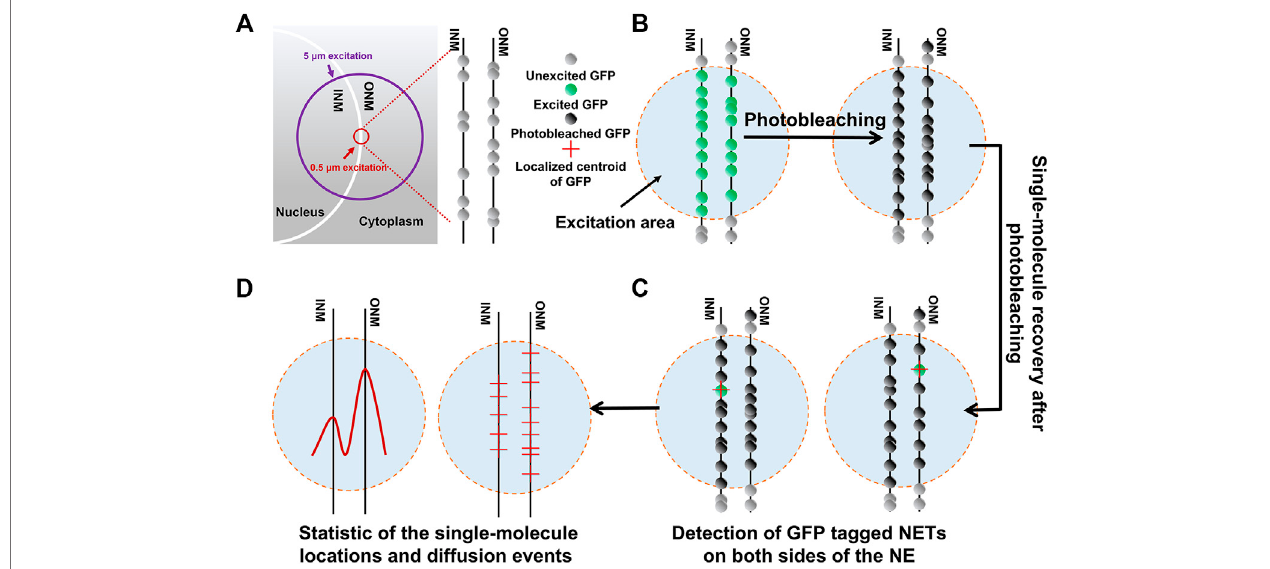
FIGURE2| StudyonNETdistributionalongtheNEbysingle-pointsmFRAP. (A) SchematicoftheGFP-taggedNETalongtheNEvisualizedinHeLacelltransfected system.ThebrighthalfcirclesrepresenttheNE.ThepurplecircleindicatestheilluminationareausuallyusedinbulkFRAPexperimentsandtheredcircleindicatessingle- point illumination area limited to 0.5 μ m used on single molecule level. (B) Photobleaching of both GFP-fused INM and ONM by excitation laser at a high power. (C) Single-molecule photorecovery of the unbleached NETs diffused into the laser excitation area again, as well as those that diffuse into the area are photobleached. (D) Locations and diffusion events of NETs along the ONM and INM of NET are compiled. Adapted from Ref. [48].